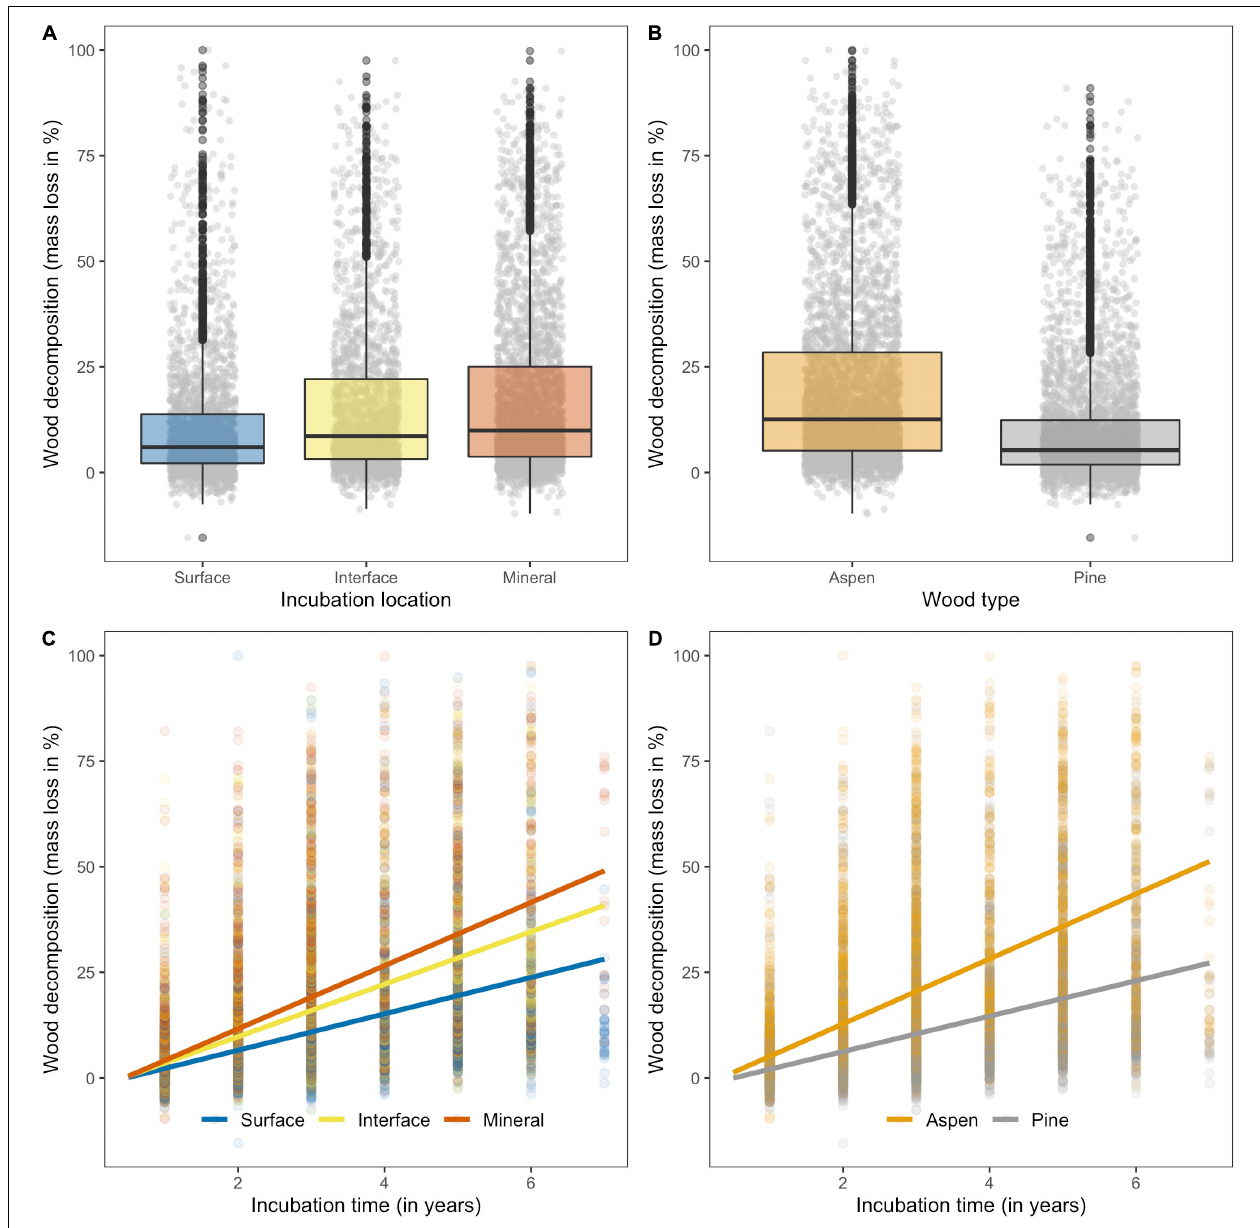
FIGURE 2 | Effects of incubation location, wood type, and incubation time on wood decomposition (mass loss in %) across 44 forest sites located in the northern hemisphere. (A) Differences in decomposition of wood stakes placed on top of the surface organic horizon (surface; n = 2,337), the interface between the surface organic horizon and mineral soil (interface; n = 2,036) and in the mineral soil (mineral; n = 2,904). Both wood types (aspen and pine stakes) and all incubation times (1–7 years) were included. (B) Differences in decomposition between aspen ( n = 3,583) and pine stakes ( n = 3,694; all locations and times included). (C) Linear effects model (LMM, Table 1 ) predicting wood decomposition depending on incubation time for wood stakes placed on top of the surface organic horizon, the interface between the surface organic horizon and mineral soil (all locations and times included). (D) Linear effects model (LMM, Table 1 ) predicting wood decomposition of different wood types depending on incubation time (all locations and times included). Panels (A,B) represent boxplots of raw data showing the median (50th percentile), 25th and 75th percentile of the data across sites. Individual measures are shown in the background as dots. All statistical results can be found in Table 1